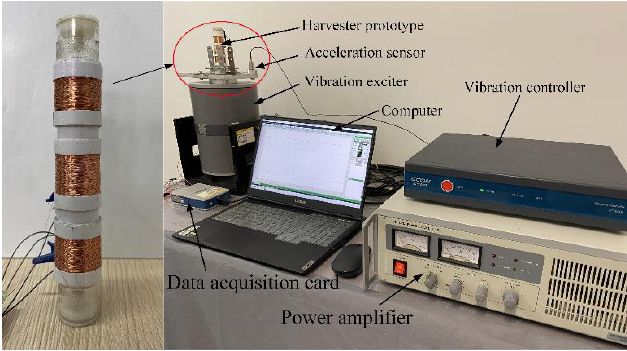
Figure 2. Experimental platform and data acquisition system.